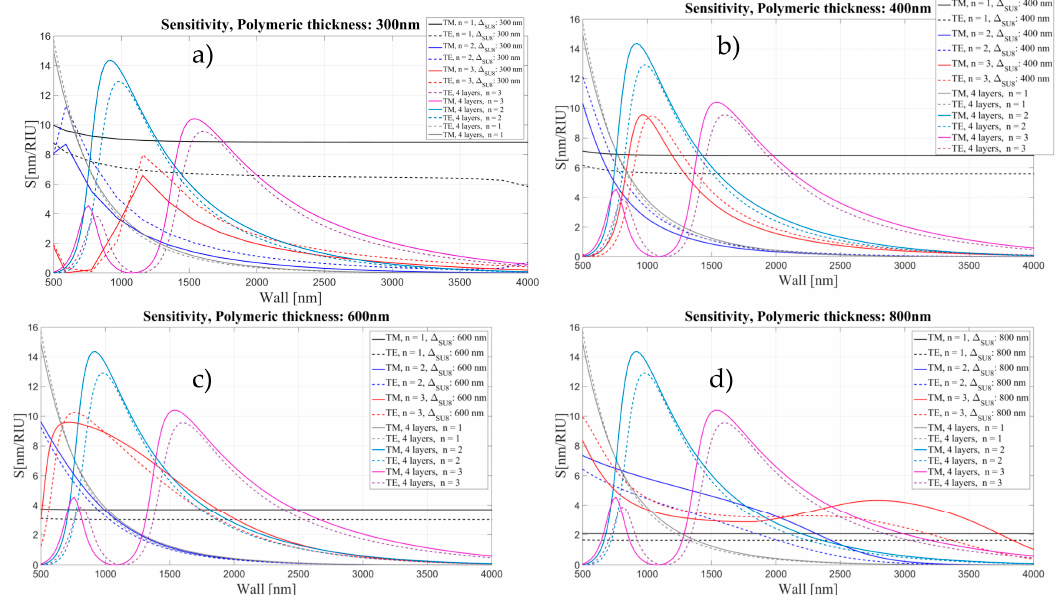
Figure 17. Sensitivity (nm/RIU) for the four- and five-layer models as a function of wall thickness for two different polarizations and three mode orders, corresponding to different thickness of polymeric layer: ( a ) 300 nm; ( b ) 400 nm; ( c ) 600 nm; and ( d ) 800 nm.